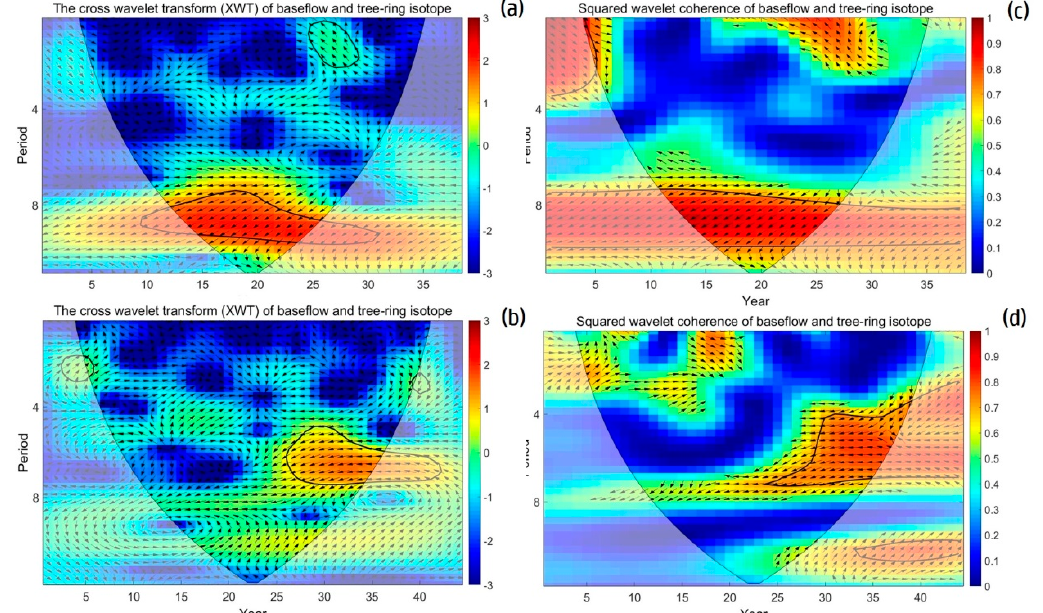
Figure 9. ( a ) Cross-wavelet transform of the Ili baseflow and tree-ring isotopes. ( b ) The wavelet coherence between the Ili baseflow and the tree-ring isotopes. ( c ) Cross-wavelet transform of the Manas baseflow and tree-ring isotopes. ( d ) The wavelet coherence between the Manas baseflow and tree-ring isotopes. The 5% significance level against the red noise is shown as a thick contour. The relative phase relationship is shown as arrows (with in-phase pointing right and antiphase pointing left). Arrows indicate the phase of the coherence, where the right is in-phase and the left is antiphase; note that significant regions all show an in-phase relationship, which supports the idea that there may be a simple cause and effect relationship between the two phenomena.